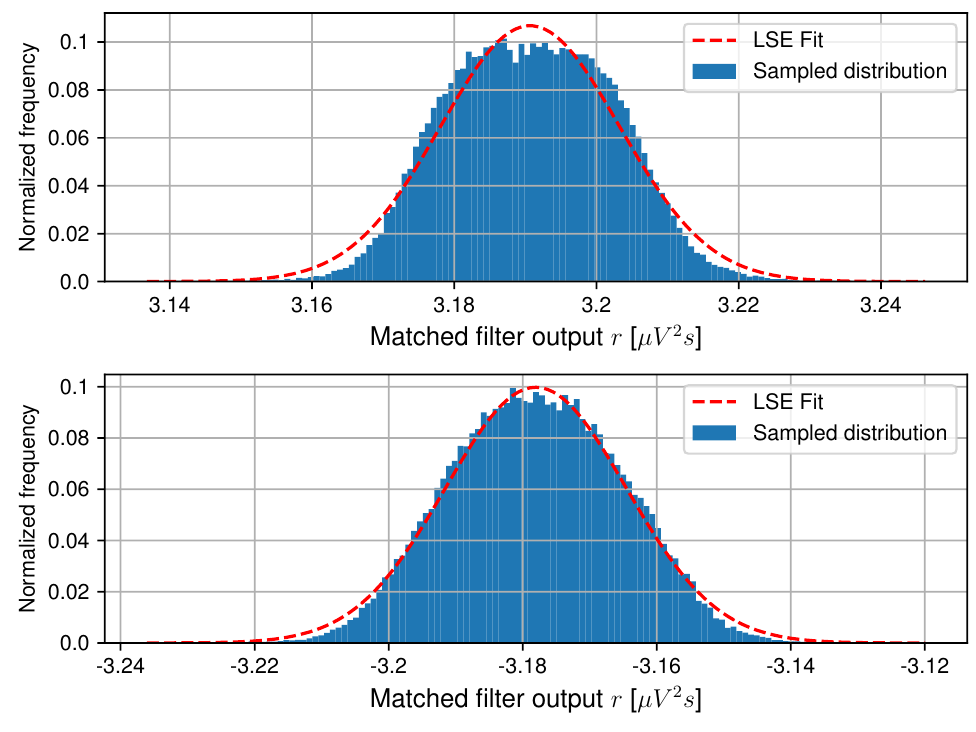
Figure 10. Measured distribution and least square error (LSE) fit of R for transmitted ‘1’-bits (top) and ‘0’-bits (bottom) at θ = 0 ◦ for T b = 250 µ s using setup A [17].